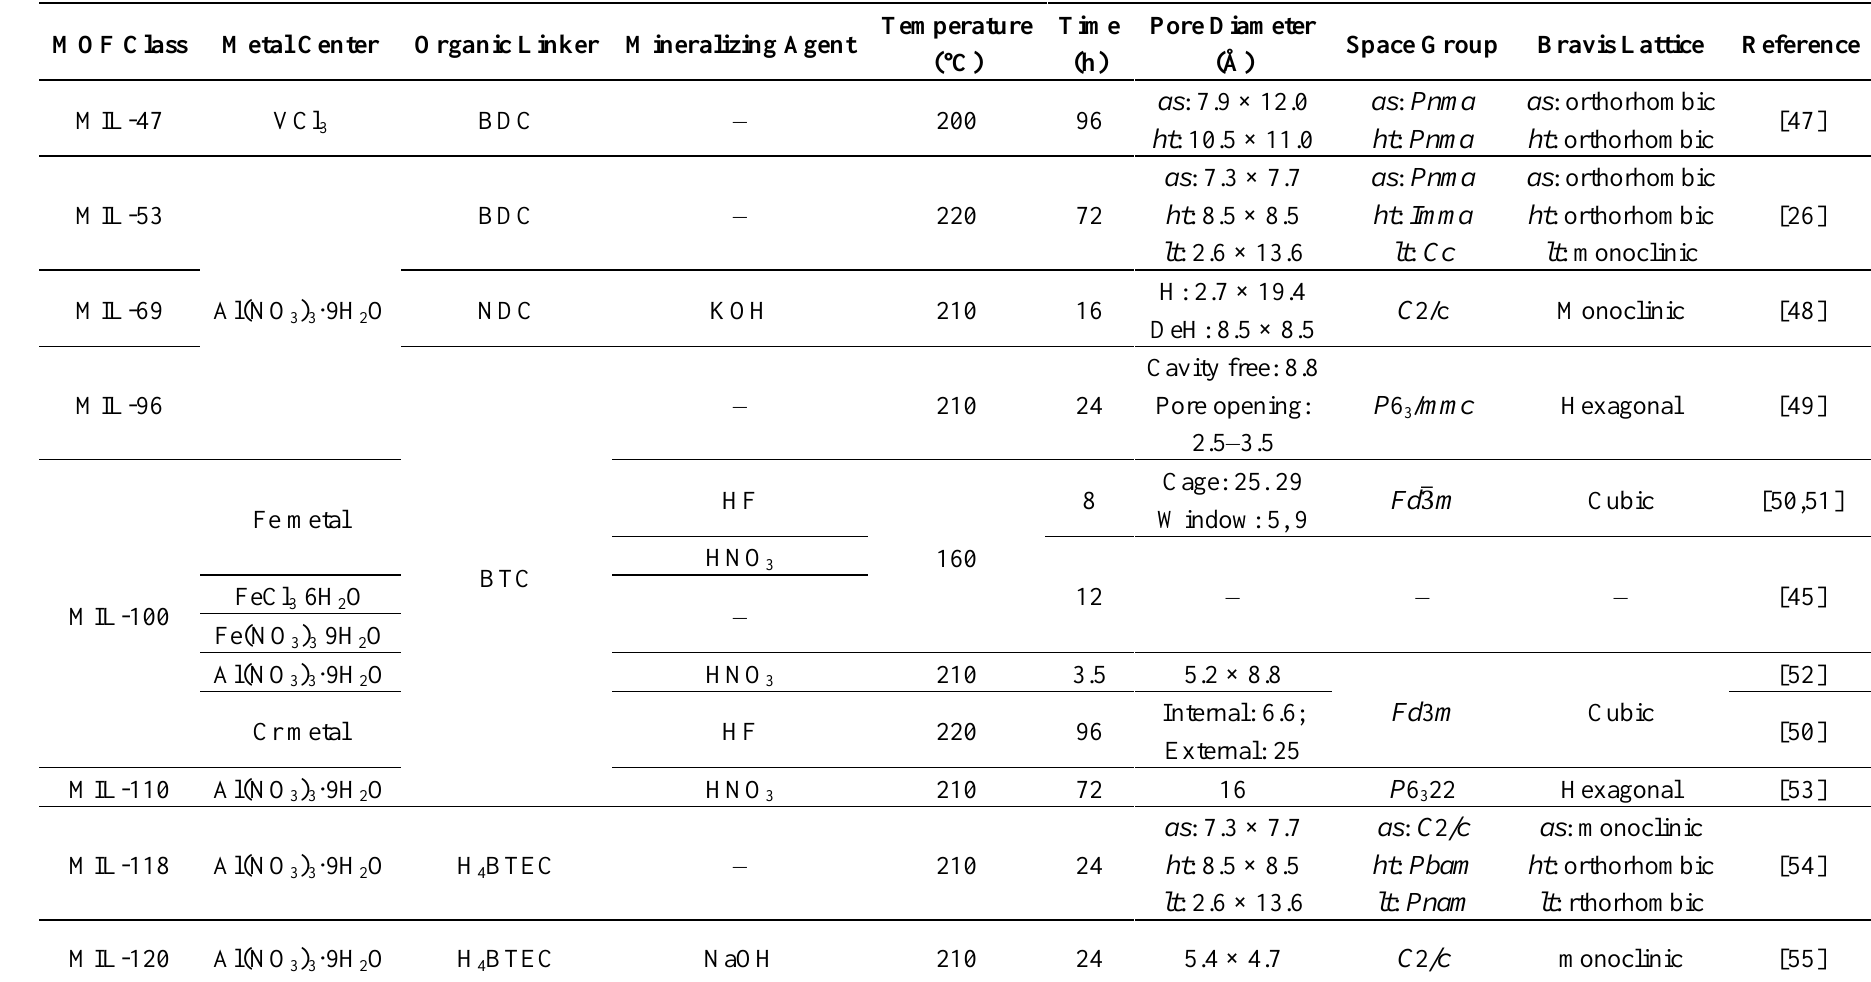
Table 1. MOFs Synthesized from Hydrothermal